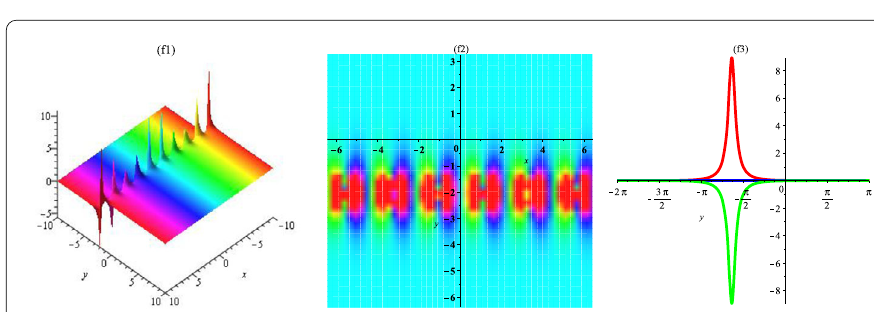
Figure 10 For solution of (3) u , v , w , c i = 0, t = 1, z = 10, (f1) 3D plot (f2) density plot and (f3) 2D plot with spaces x = –3,0,3